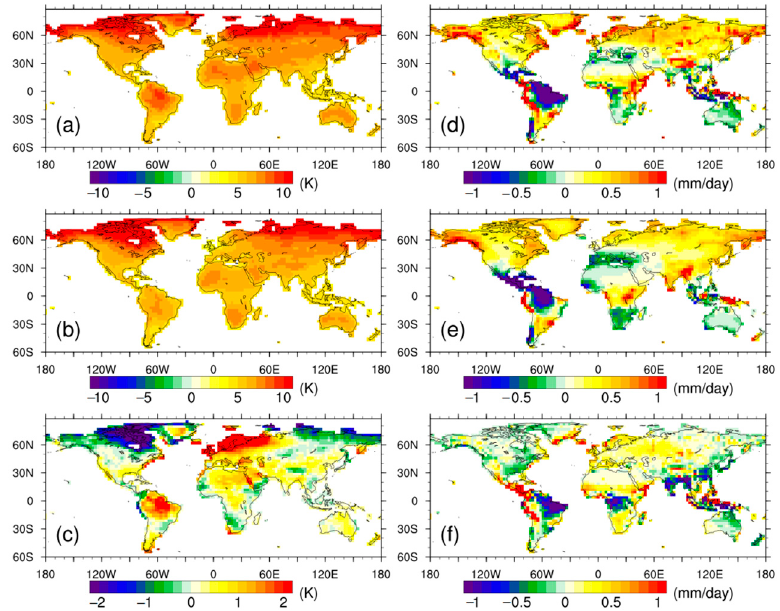
Figure 2. Spatial distribution of anomalies in surface air temperature (TAS, units: K) for ( a ) CAS- ESM2, ( b ) multi-model ensemble mean, and ( c ) their differences. ( d – f ) are the same as ( a – c ) but for precipitation (Pre, units: mm day − 1 ).